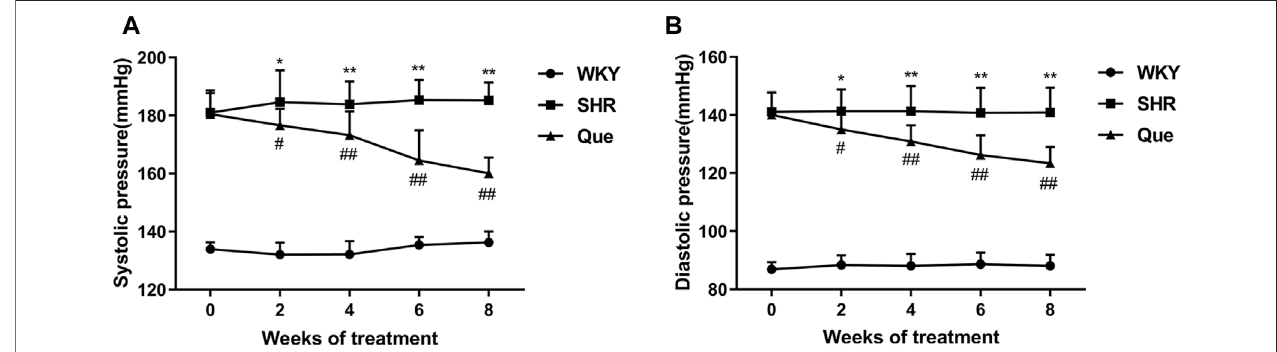
FIGURE1 | Quercetin decreasessystolic blood pressure (SBP) and diastolic blood pressure (DBP) inspontaneously hypertensive rats (SHRs). (A) SBP indifferent rat groups at each time point (n (cid:1) 8). (B) DBP in different rat groups at each time point (n (cid:1) 8). Dataare mean ± SD. * p < 0.05, ** p < 0.01 vs WKY group; # p < 0.05, ## p < 0.01 vs SHR